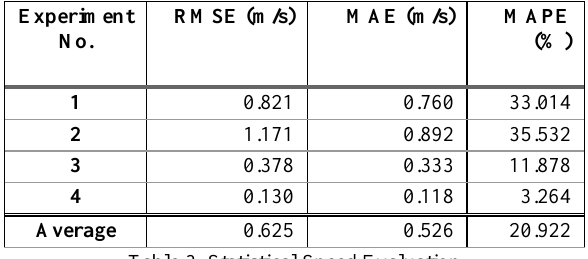
Table 3. Statistical Speed Evaluation